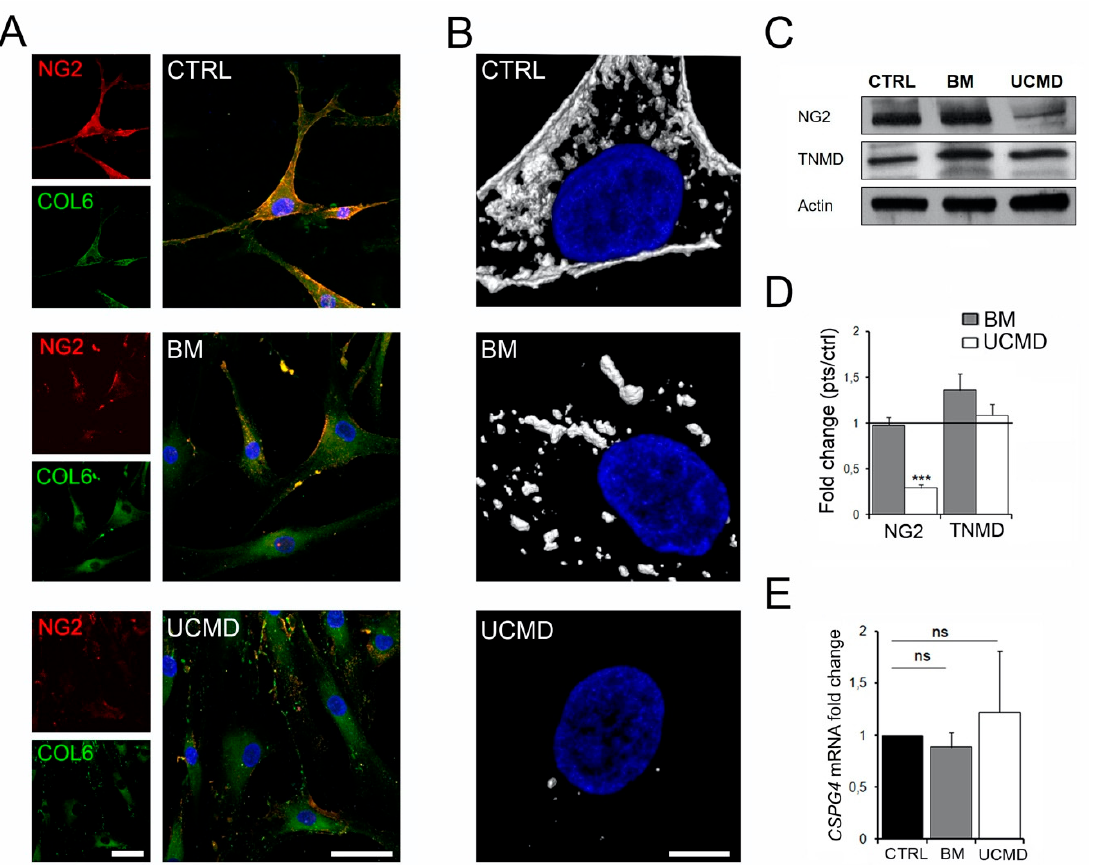
Figure 2. Collagen VI-NG2 axis is disrupted in tendon fibroblasts from BM and UCMD patients. ( A ) Confocal microscopy analysis of tendon fibroblasts double-labeled with anti-collagen VI (COL6, green fluorescence) and NG2 (NG2, red fluorescence) on proliferating samples from control (upper panels), BM (middle panels), and UCMD (lower panels). Collagen VI co-localizes with NG2 at the cell membrane of control cells. Note the moderate reduction of NG2 in BM cells, which correlates with the altered collagen VI signal. NG2 signal is reduced in UCMD cells, while collagen VI staining is dispersed among the cells. Nuclear staining, DAPI. Scale bar, 40 μ m. ( B ) Co-localization analysis of the representative perinuclear area in collagen VI-NG2 double-labeled samples, from control (upper panel), BM (middle panel), and UCMD (right panel). White signal identifies areas of high co-localization. Nuclear staining, DAPI. Scale bar, 10 μ m. ( C ) Western blot analysis of NG2 in cell cultures of control (CTRL), BM, and UCMD cell lysates shows reduced NG2 expression in the UCMD cells. In BM cells, NG2 is expressed at levels similar to that of the control cell lysate. Tenomodulin (TNMD), used as a marker of tendon cells, and actin, used as a loading control, do not show differences between control and patient cell lysates. ( D ) Densitometric analysis of NG2 and TNMD. Protein levels were calculated as relative intensity with respect to actin. The respective protein levels in BM and UCMD cells were compared to the control (CTRL; showed by the dark line, set as 1) ± SE. *** p < 0.001. ( E ) CSPG4 mRNA analysis in UCMD and BM cells showing no obvious differences with respect to control (CTRL) cells. Data represent mean ± SE of three independent experiments; ns, non-significant.